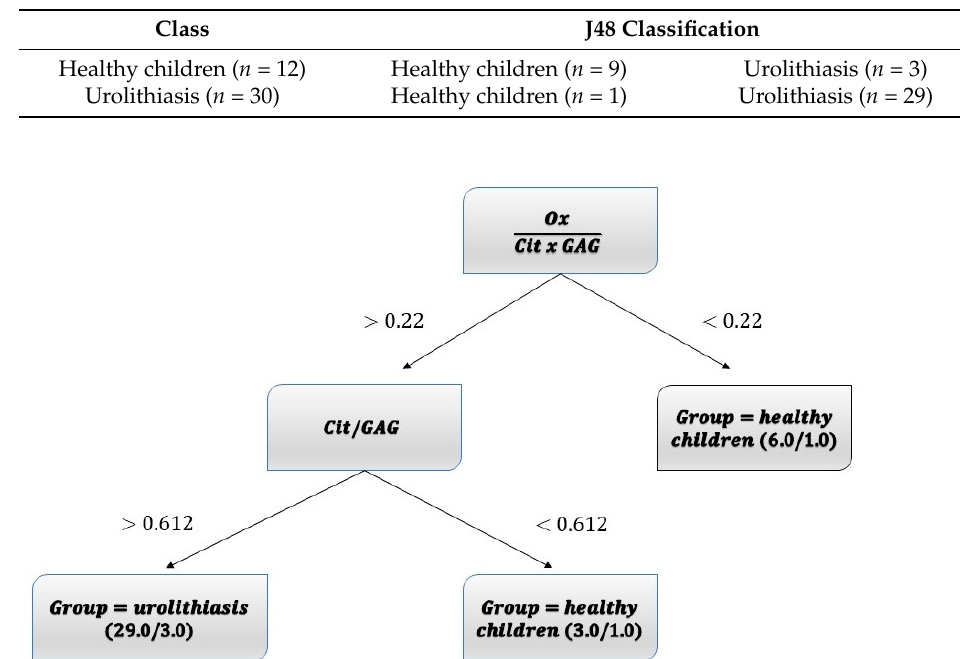
Figure 2. Classification tree for discrimination between OC healthy children and children with urolithiasis. The classification tree has two decision nodes and three decision leaves (for clarity, all variables are designated by full names instead by abbreviations, except for glycosaminoglycans (GAG).